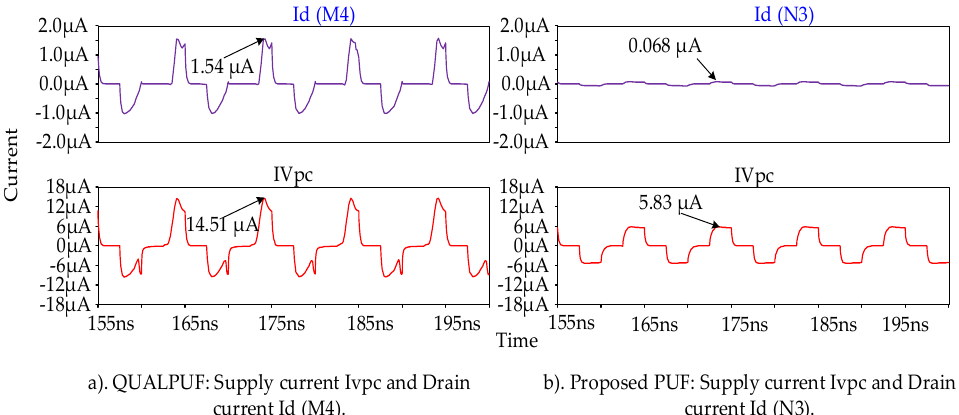
Figure 14. Current traces of charging and discharging output nodes when Cb signal at logic “0” level; ( a ) QUALPUF circuit (refer to Figure 2a), and ( b ) proposed PUF (refer to Figure 3a).